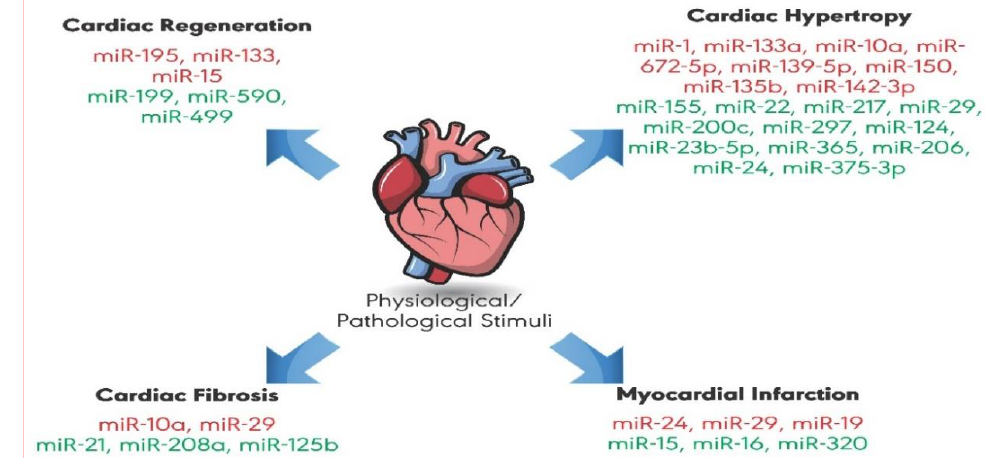
Figure 1. MicroRNAs (miRNAs) play a role in physiological and pathological cardiac remodeling. Some miRNAs have a protective role against cardiovascular diseases, whereas others promote extensive cardiac remodeling, leading to disease. The red color indicates miRNAs that negatively regulate cardiac remodeling. The green color indicates miRNAs having a positive regulatory role.